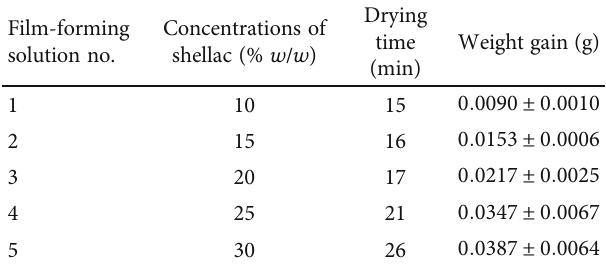
Table 1: Evaluation of drying time and weight gain of extract-free nail lacquers. Film-forming solution